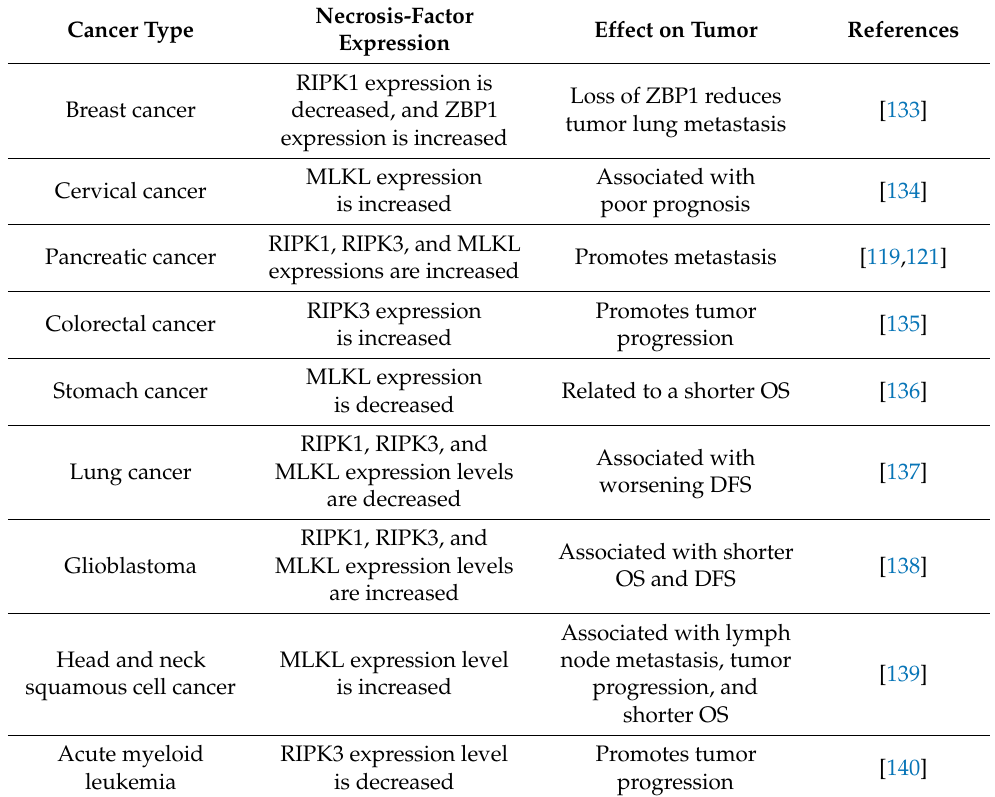
Table 2. Expression of necroptosis factor in cancer and its impact on cancer